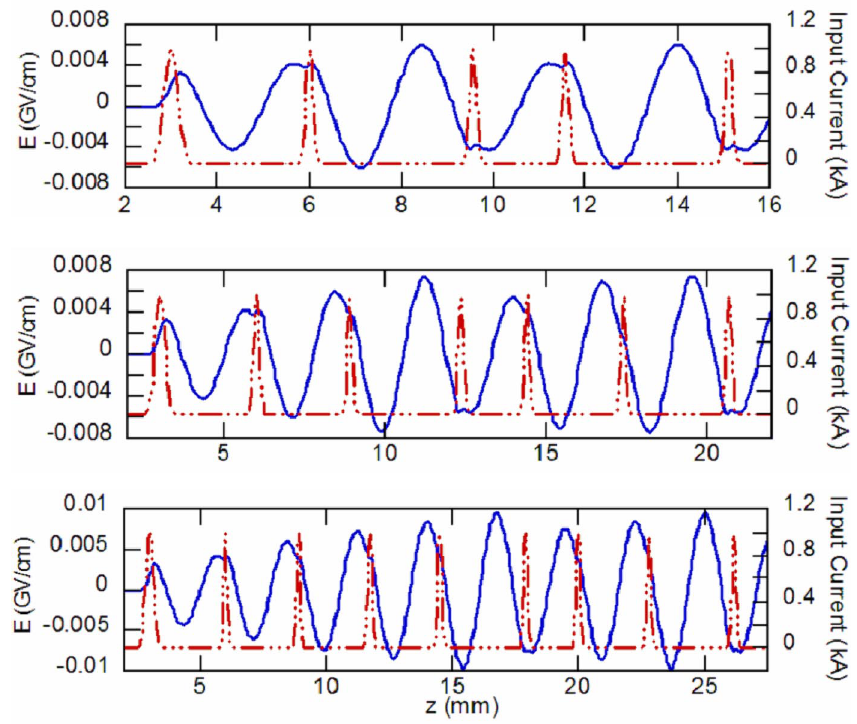
FIG. 3. (Color) Axial bunch current (dashed line) and longitudinal plasma wakefields for identical bunches with varied spacing: (a) two initial drive bunches, (b) three initial drive bunches, and (c) five initial drive